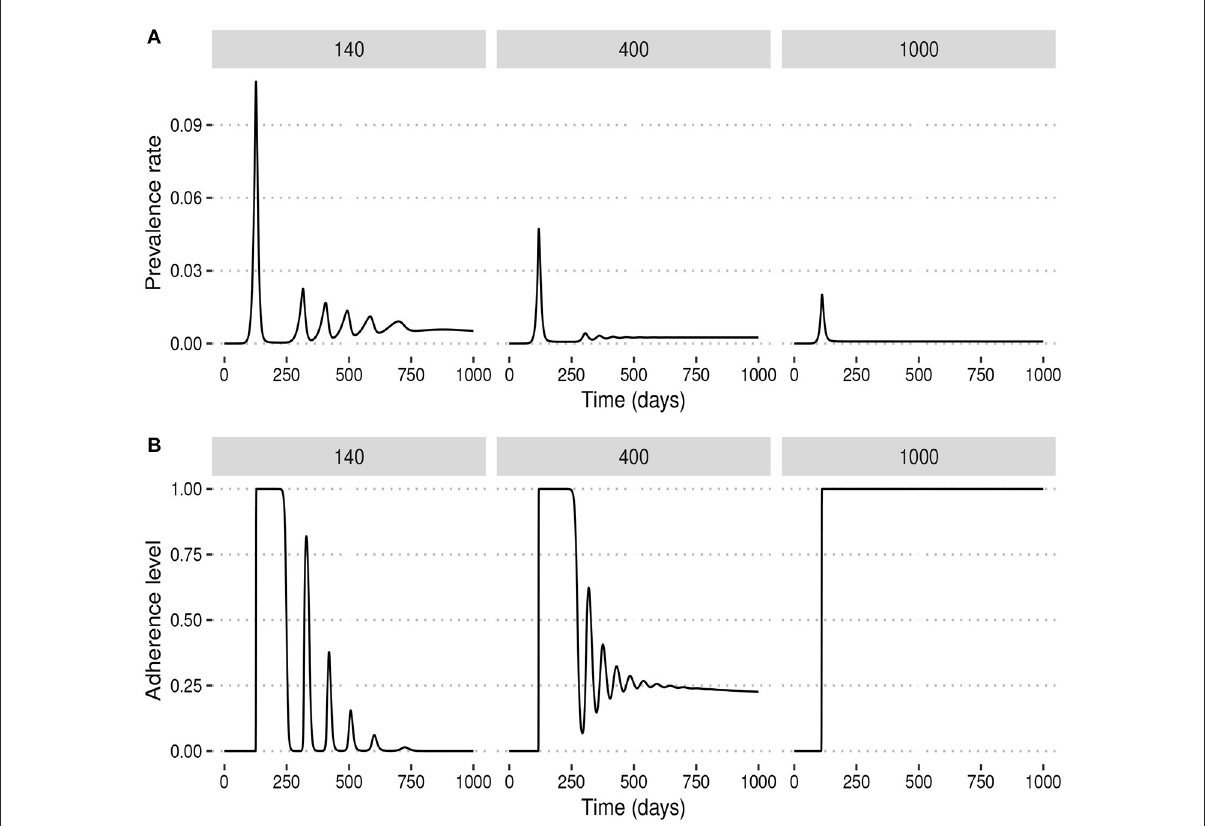
FIGURE6 Behavior at equilibrium (endemic) for different values of the ω . For low values of ω , public tolerance for the disease is high and the system converges to a state where there is no adherence to NPIs during the endemic stage of the disease. For higher values of ω , however, NPI adherence during the endemic stage can be either partial or total depending on how large the value of ω is. (A) Prevalence rates. (B) Adherence